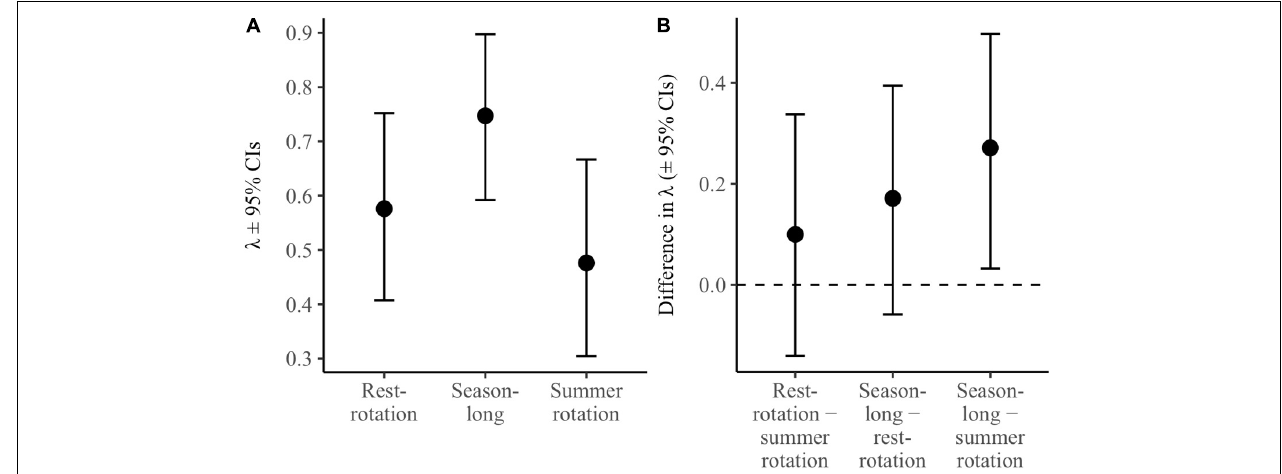
FIGURE 3 | Estimated population growth rates ( A ; λ ± 95% credible intervals) for each grazing system using a female-based integrated population model for sharp-tailed grouse in western Montana. Panel B depicts the relative difference between estimated growth rates ( ± 95% credible intervals) between each pair of grazing systems, with credible intervals that do not overlap zero suggesting a significant difference between the two grazing